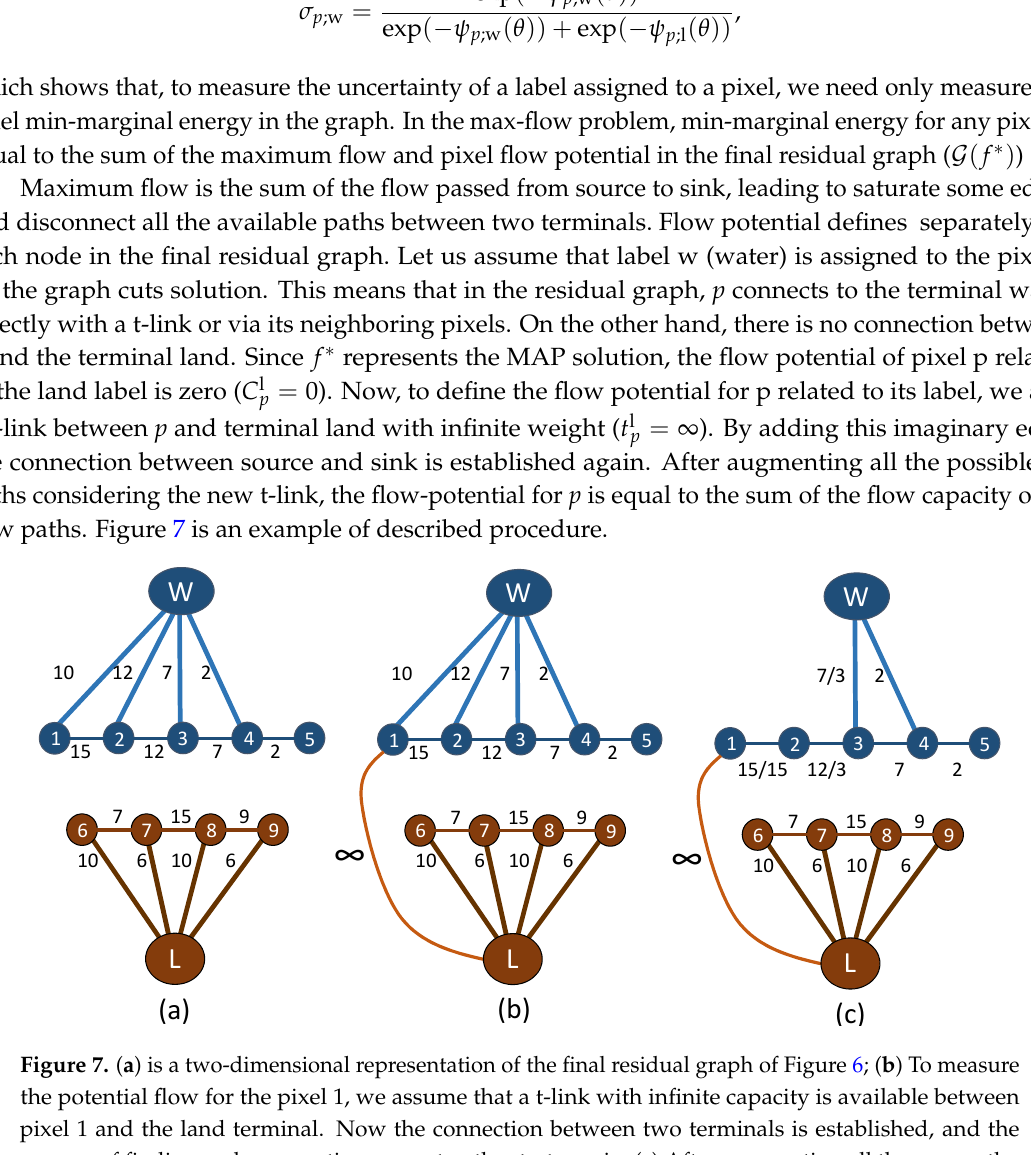
), equal to the sum of the capacity of paths 1 = 25). Additionally, C L = 0 1 1